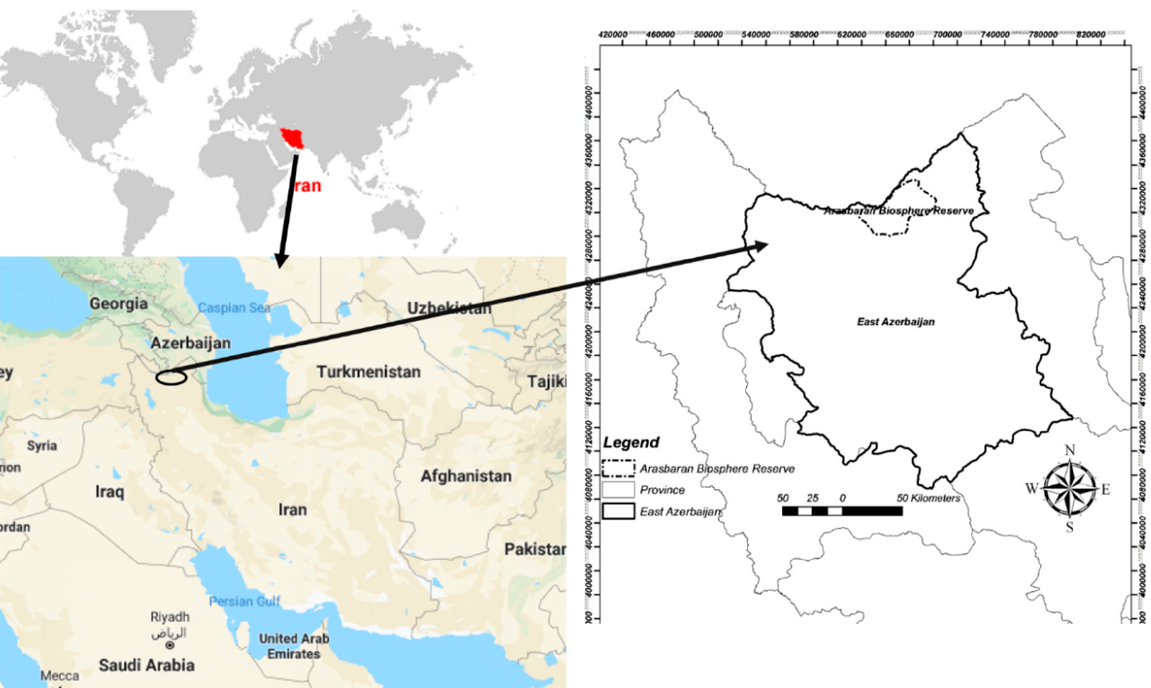
Figure 1. The location of the Arasbaran biosphere reserve in context of a global position (world map, upper left), Iran (country map, lower left), and the Province of Azerbaijan (provincial map section, right).